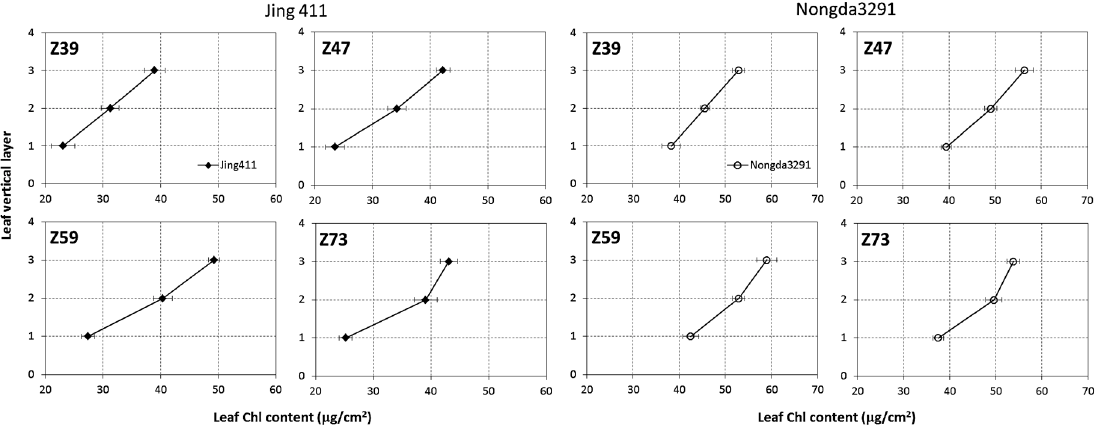
Figure 2. Vertical distribution of leaf Chl content within wheat canopies measured in 2007 during stem elongation (Z39), booting (Z47), heading (Z59) and milk-filling (Z73) stages for: Jing411 ( left ); and Nongda3291 ( right ) cultivars. The values 3, 2, and 1 on y -axis indicate the upper-, middle- and bottom-layer, respectively. Standard deviation of measurements is drawn as horizontal error bars.